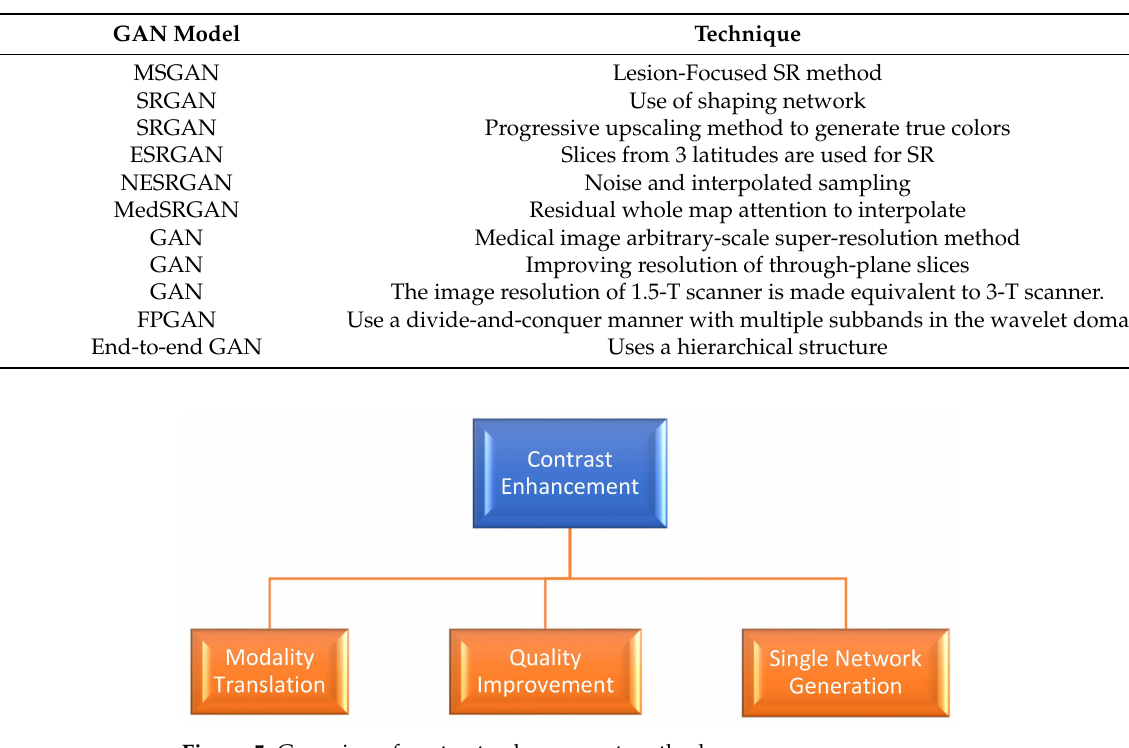
Figure 5. Grouping of contrast enhancement